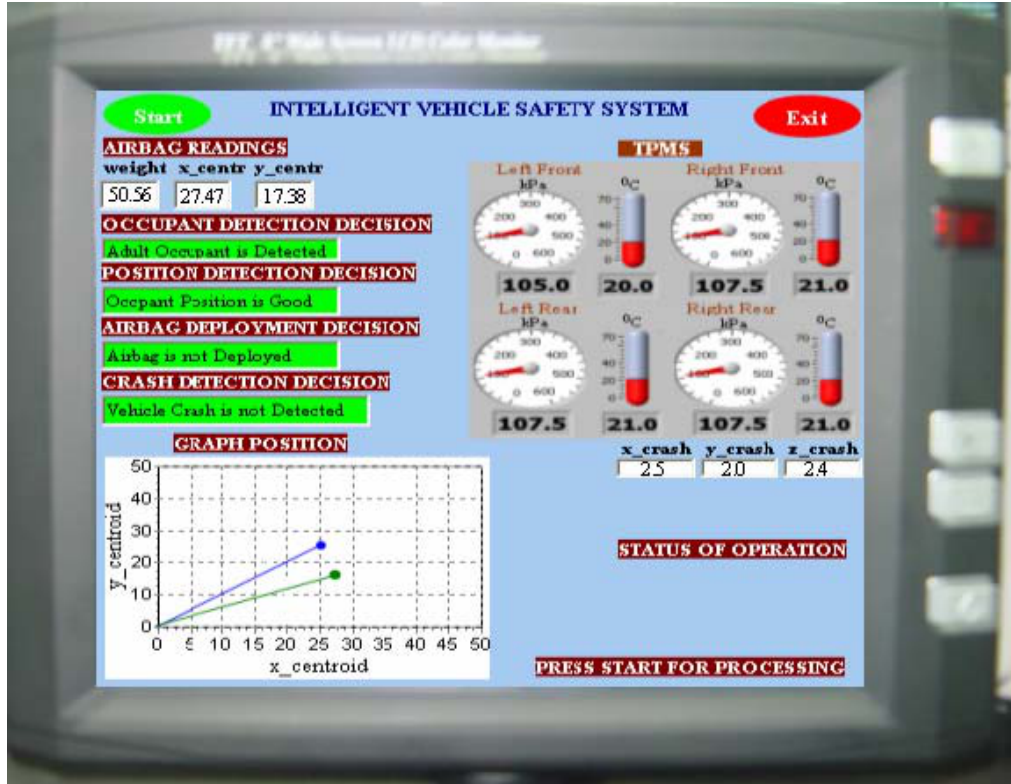
Figure 6. Display interface for the integrated